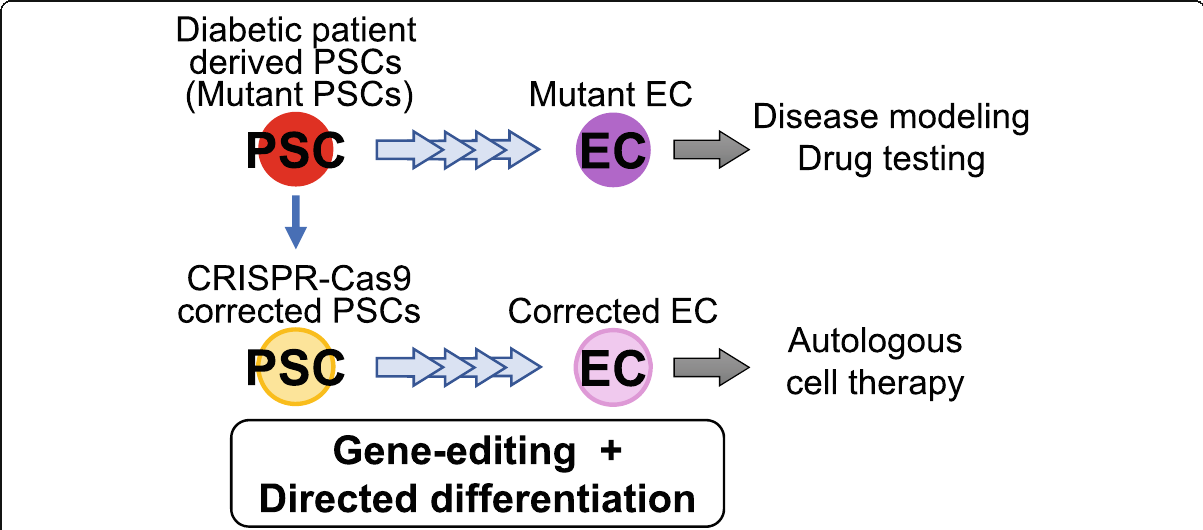
Fig. 3 Combining gene-editing and directed differentiation for the development of novel therapeutics. Patient-derived endocrine cells can be applied in disease modeling and drug testing, while corrected PSC-derived endocrine cells can be a promising source for autologous cell